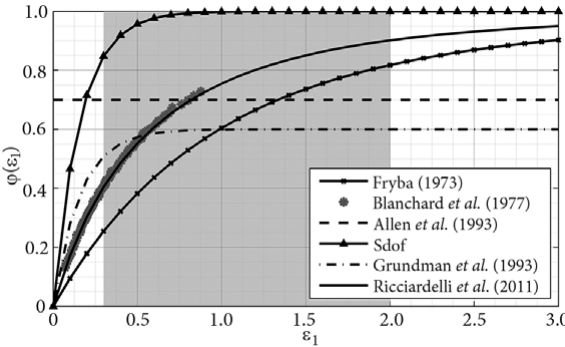
Fig. 3. TRRC values proposed by different authors for simply supported beams (Ricciardelli, Demartino